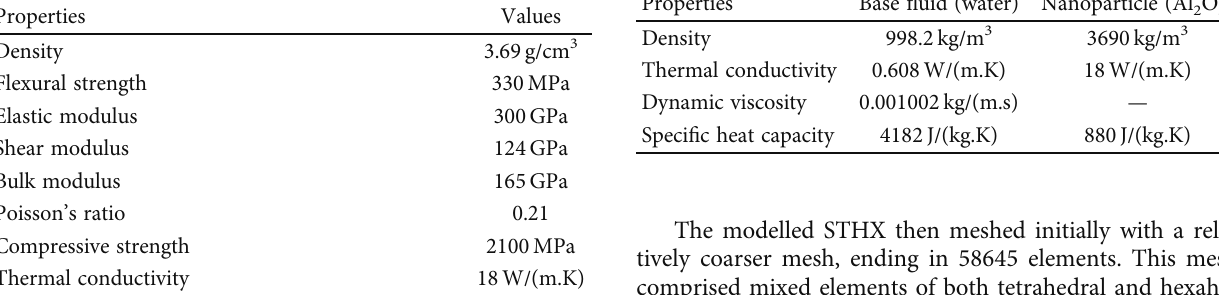
Table 4: Properties of base fl uid and